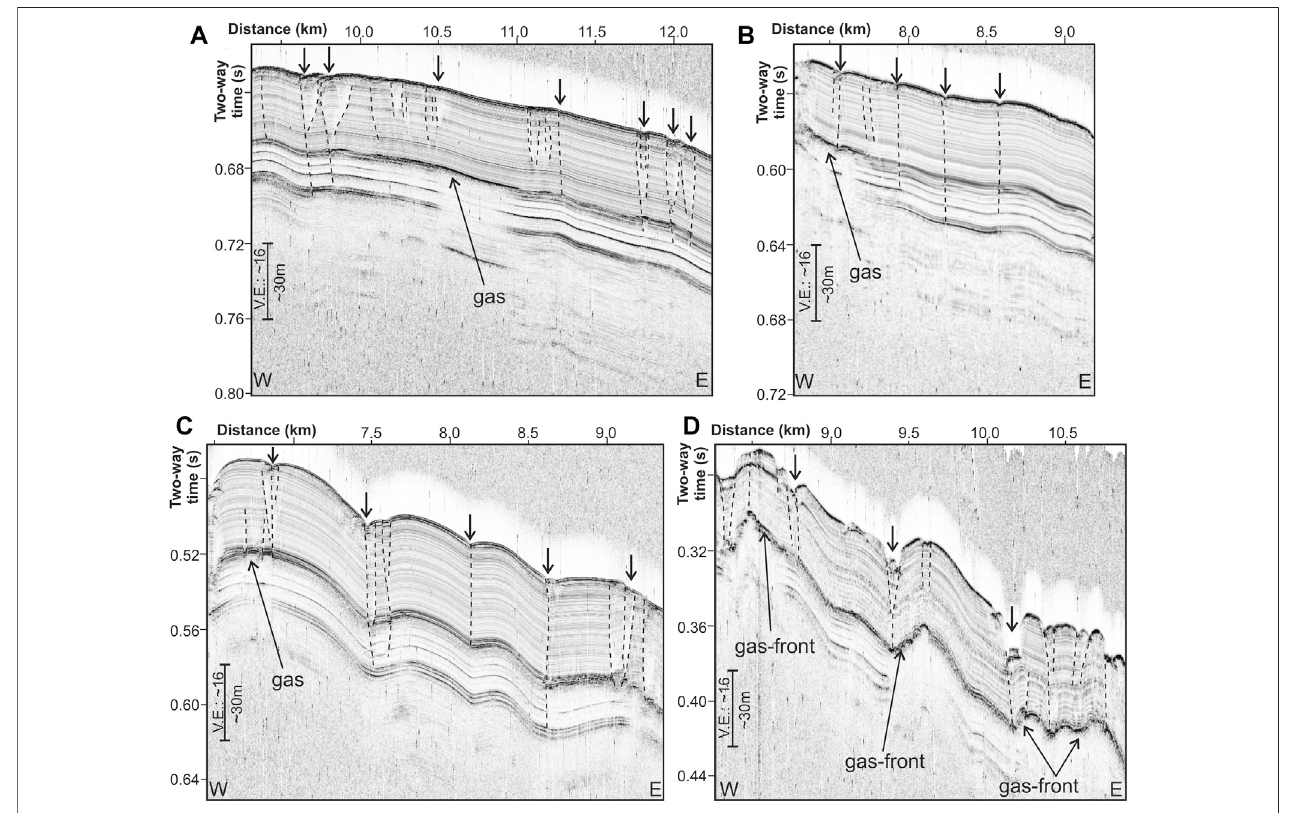
FIGURE 9 | Examples of sub-bottom pro fi ler data showing evolution of elongated depressions (marked with arrows) and faults (black dashed lines). (A) In deeper water the fault-offsets between adjacent sediment layers are below resolution limit of acoustic data and acoustic re fl ectivity is only blurred or generally decreased, (B) upward migrating gas creates slightly larger sea fl oor depressions, (C) several faults merge and, (D) create wider elongated depressions.